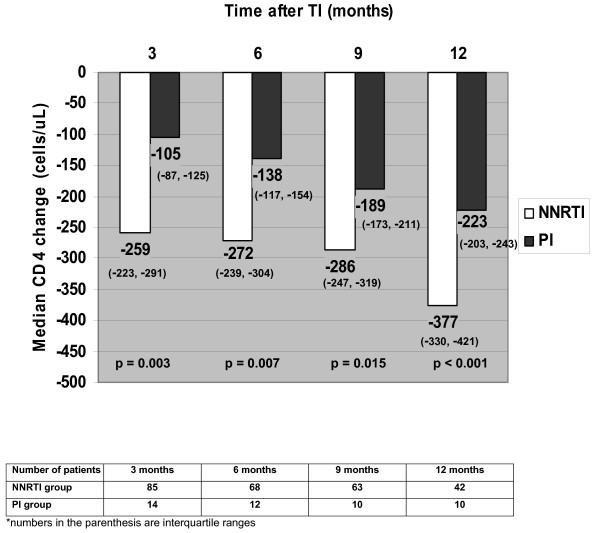
Changes of median CD4 cell counts after TI in NNRTI and PI group.